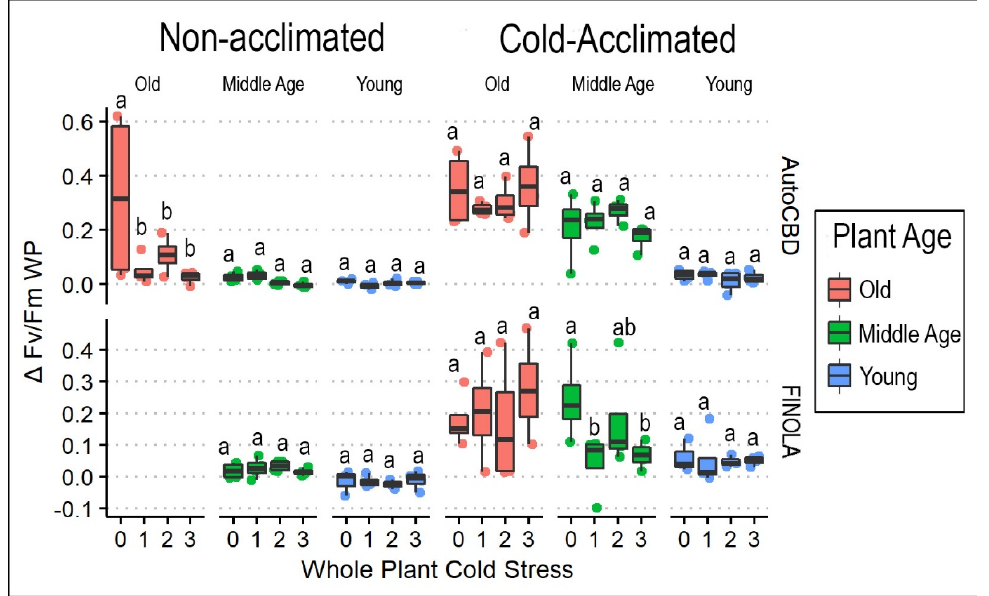
Figure 2. Δ Fv/Fm WP box plots comparing whole-plant cold stress and plant age for cold-acclimated and non-acclimated ‘AutoCBD’ and ‘FINOLA’ plants. Data represent the difference between Fv/Fm taken before and after whole-plant cold stress. Non-acclimated plants received no cold acclimation period, and cold-acclimated plants were subject to 10 days at 10 °C. Cold stress consisted of no exposure, 0 (control); a single 3 h − 0.5 °C exposure, 1 ; two consecutive 3 h − 0.5 °C exposures separated by 24 h, 2 ; and three 3 h − 0.5 °C exposures separated by 24 h, 3 . Plant age treatments include oldest plants, middle-age plants, and youngest plants (68, 54, and 40 days old on the day of whole-plant cold stress, respectively). Y axis scale differs between acclimation treatments to accurately reflect data ranges. Lowercase letters indicate significant differences ( p < 0.05) between treatments (Tukey’s